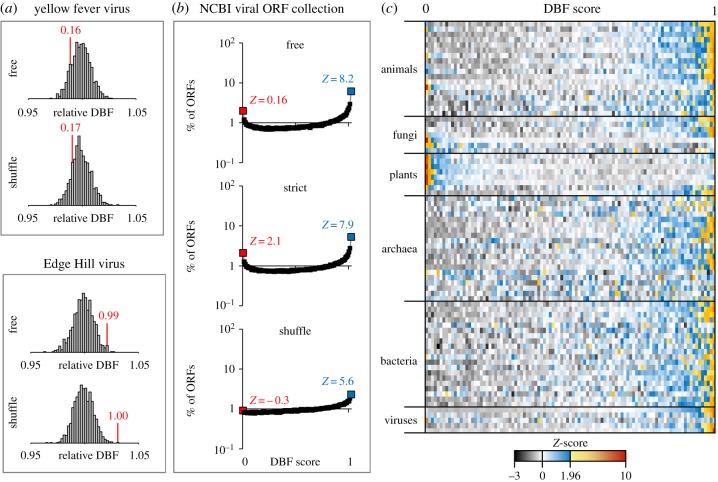
(a) DBF of aORFs from mosquito-borne RNA viruses for the purpose of illustration. The X-axis shows the distribution of DBFs relative to the average value of all aORFs. Genomes of the yellow fever virus and the Edge Hill virus both encode a single polyprotein. DBFs and the corresponding DBF scores are indicated in red. Only the ORF of the Edge Hill virus shows an exceptional DBF which is considerably higher than the corresponding aORFs (DBF scoremodel0 = 0.99, DBF scoremodel2 = 1.00). (b) The analysis of DBF scores for all available viral ORF sequences reveals a consistent and significant enrichment for extremely high DBF scores. (c) Lines in the heatmap represent species; rows represent DBF scores from 0 to 1 in steps of 0.01 using model2 (shuffle). The colour indicates row Z-scores with Z-scores above 1.96 (p
< 0.05 for the two-tailed hypothesis) indicated in shades from yellow to red. Lines for viruses represent dsDNA, dsRNA, ssDNA, ssRNA(−) and ssRNA(+) viruses.